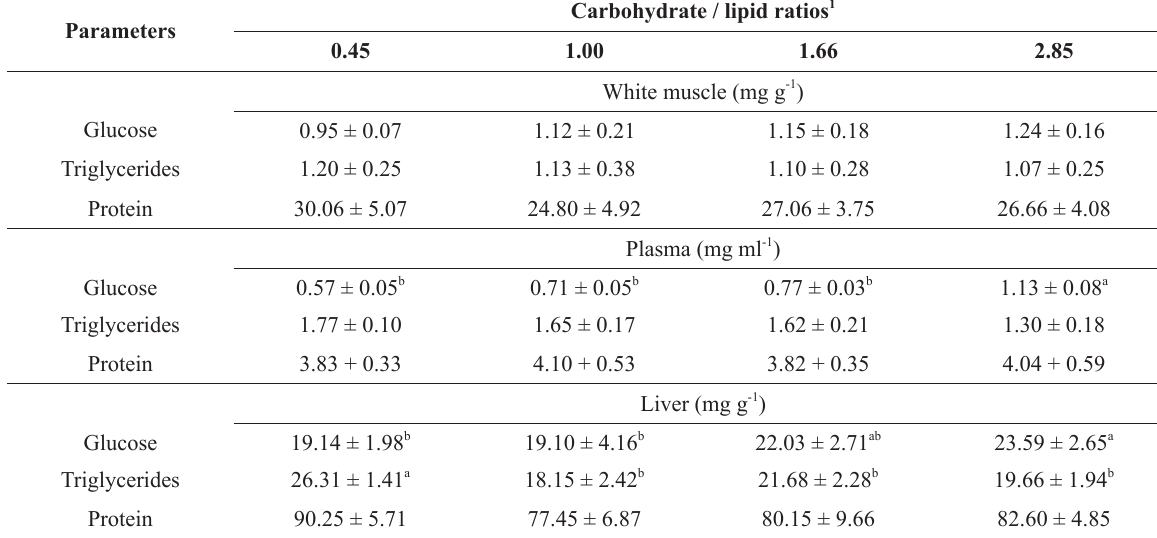
The plasma (mg.dL -1 ), liver (mg.g -1 ) and white muscle (mg.g -1 ) compositions of the juvenile Pseudoplatystoma ssp fed the experimental diets for 60 days. The means in the same row with different superscripts are significantly different at (P<0.05).